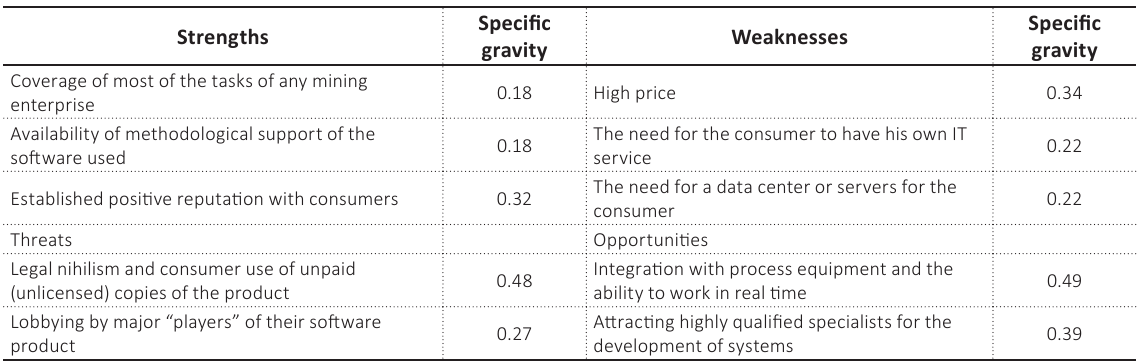
Table 2. Strategic analysis